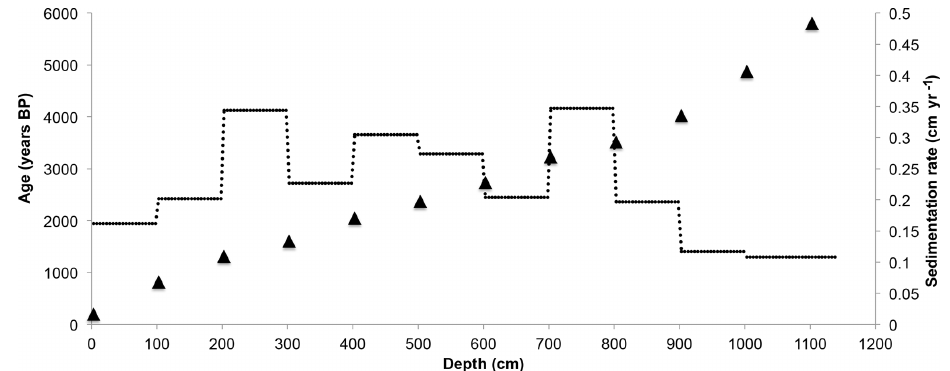
Figure 3. Age–depth model of core MSM45-31-1. Black triangles mark the calibrated ages of the AMS radiocarbon dates. The black dotted line marks the sedimentation rate (cmyr − 1